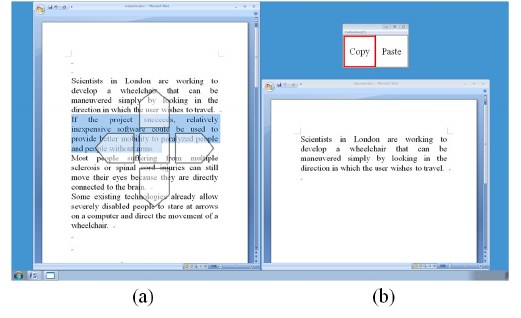
Fig. 11. The screenshot of the task windows